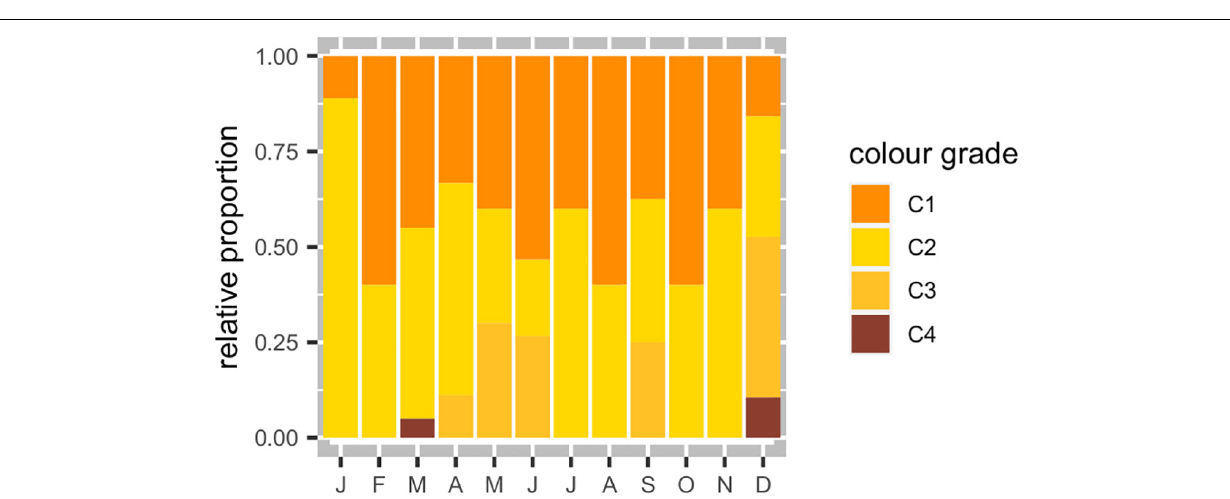
( F = 4.291, p = 0.012). The total carotenoid content was lower in summer (average 195.41 ± 34.15 µ g/g DM) with identical concentration in both males and females ( Figure 7A ),